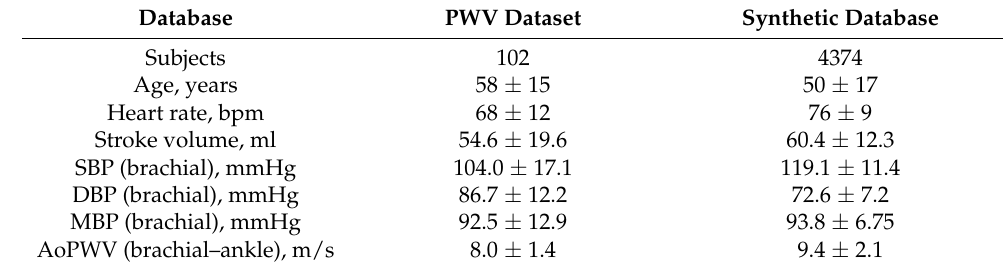
Table 1. Comparison of PWV dataset and synthetic database.